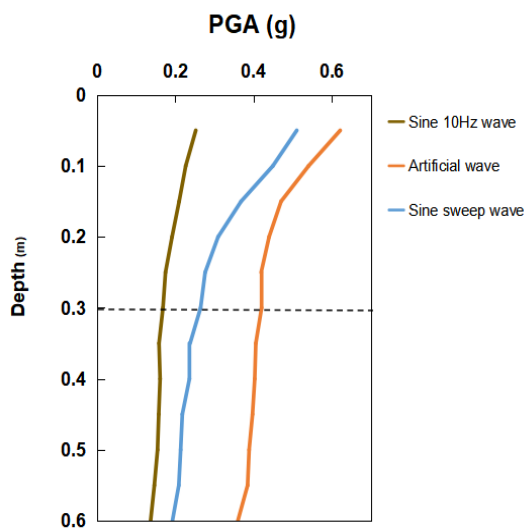
Figure 10. Peak ground acceleration by depth of flat model under different seismic waves.